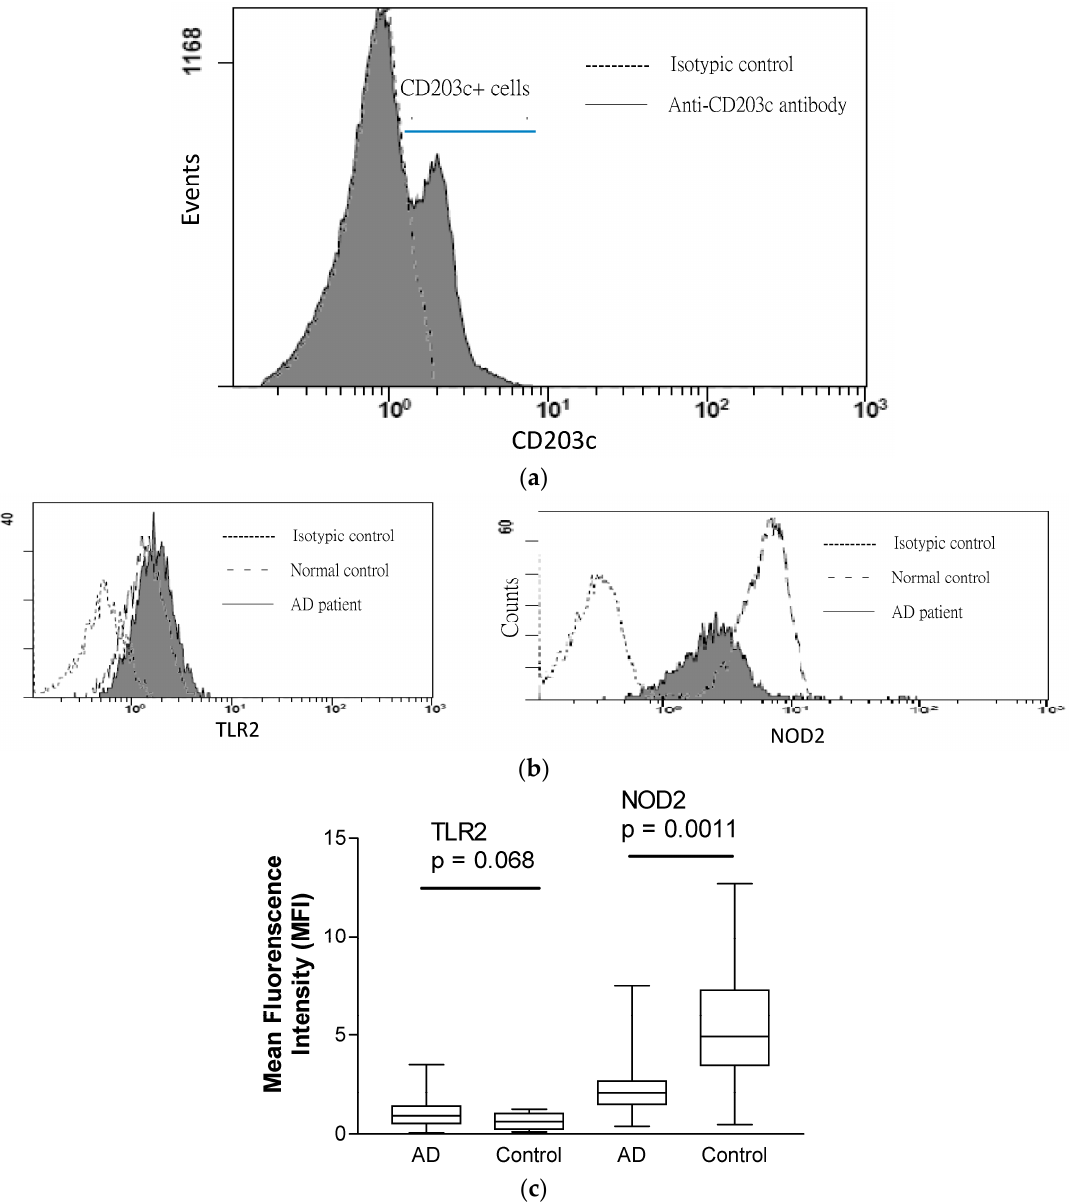
Figure 3. Expression of TLR2 and NOD2 in CD203-positive granulocytes. ( a ) Representative histogram is shown for the CD203+ cells gated from total granulocytes; ( b ) Representative histograms of the cell surface expression of TLR2 and intracellular expression of NOD2 of CD203c+ granulocytes are shown. ( c ) Box and whiskers plots showing the comparison of cell surface TLR2 and intracellular NOD2 expression (MFI) in CD203+granulocytes between AD patients and control subjects were determined by Mann-Whitney rank sum test. AD: patients with atopic dermatitis; Control: normal control subjects.